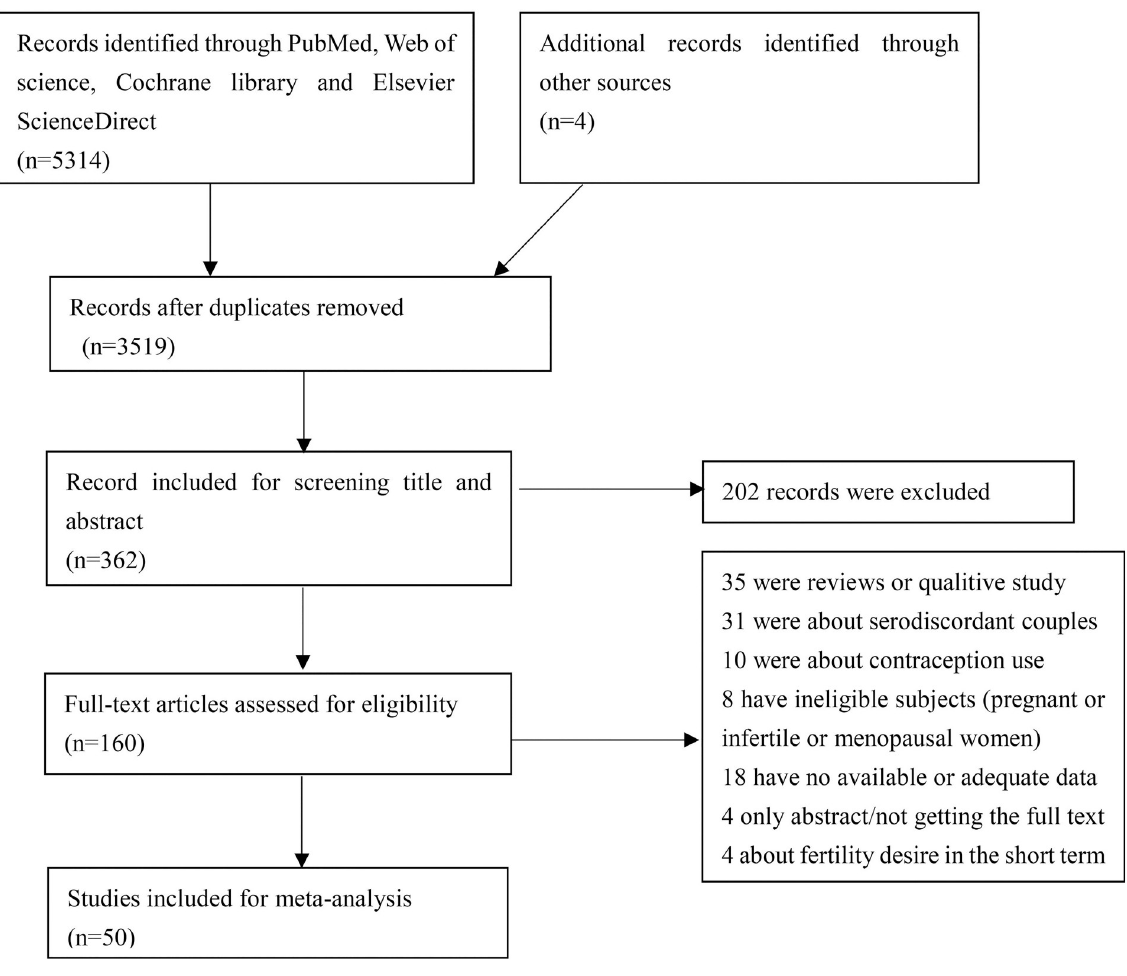
Fig 1. Flowchart of the literature